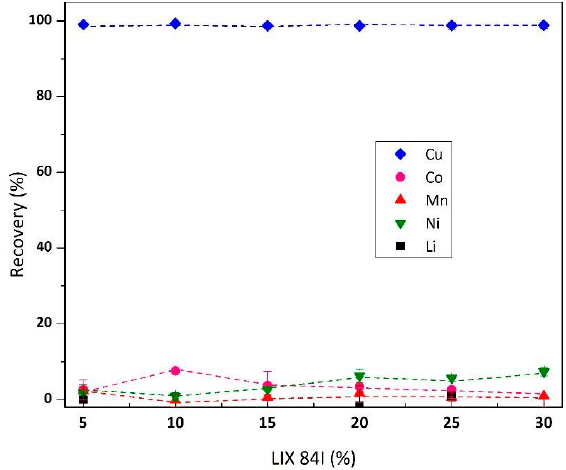
Figure 2. Effect of LIX ® 84-I concentration ( v/v ) on Cu isolation from leachate (pH 3, metal concentration in feed Cu 0.23 g/L, Co 3.54 g/L, Mn 0.16 g/L, Ni 0.14 g/L and Li 0.62 g/L).